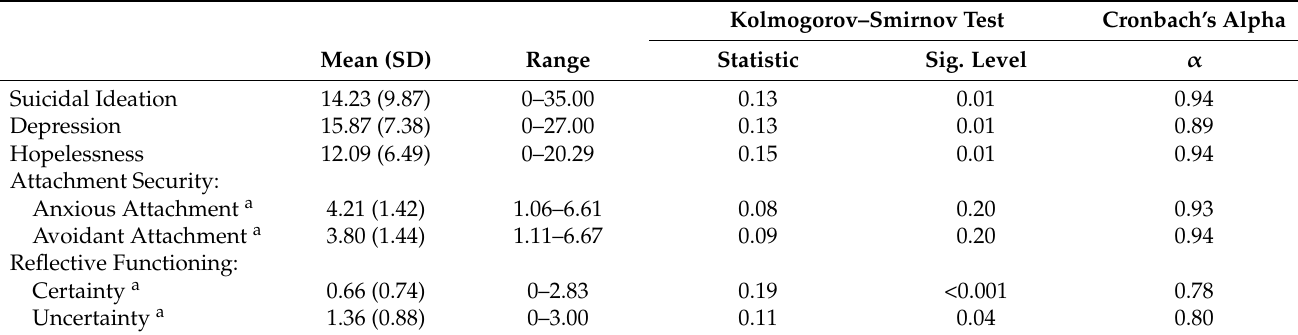
Table 2. Questionnaire measures: descriptive statistics, normality and reliability